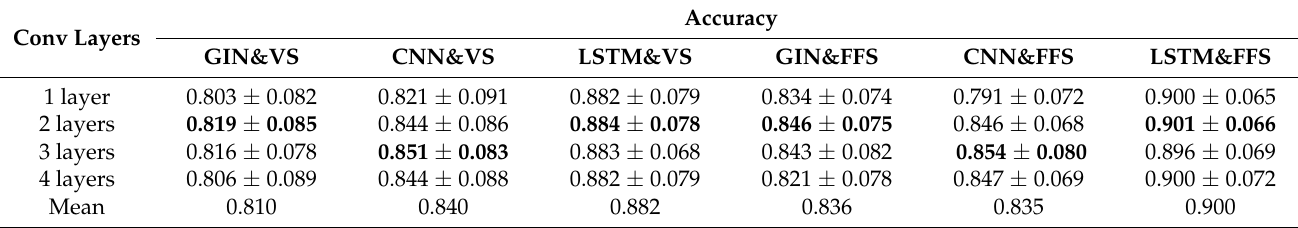
Table 5. Accuracy comparison between different numbers of network